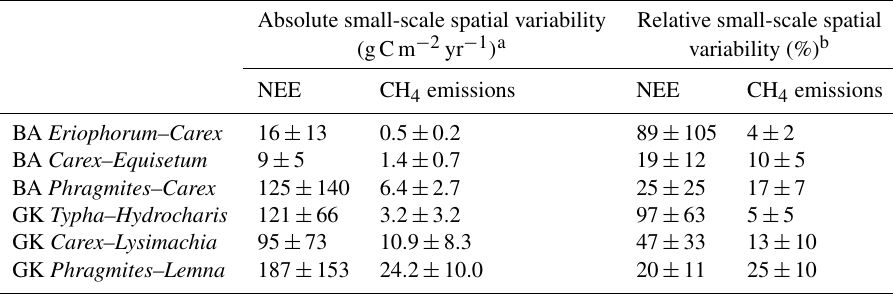
Table 3. Small-scale spatial variability of net CO 2 and CH 4 emissions. Absolute small-scale spatial